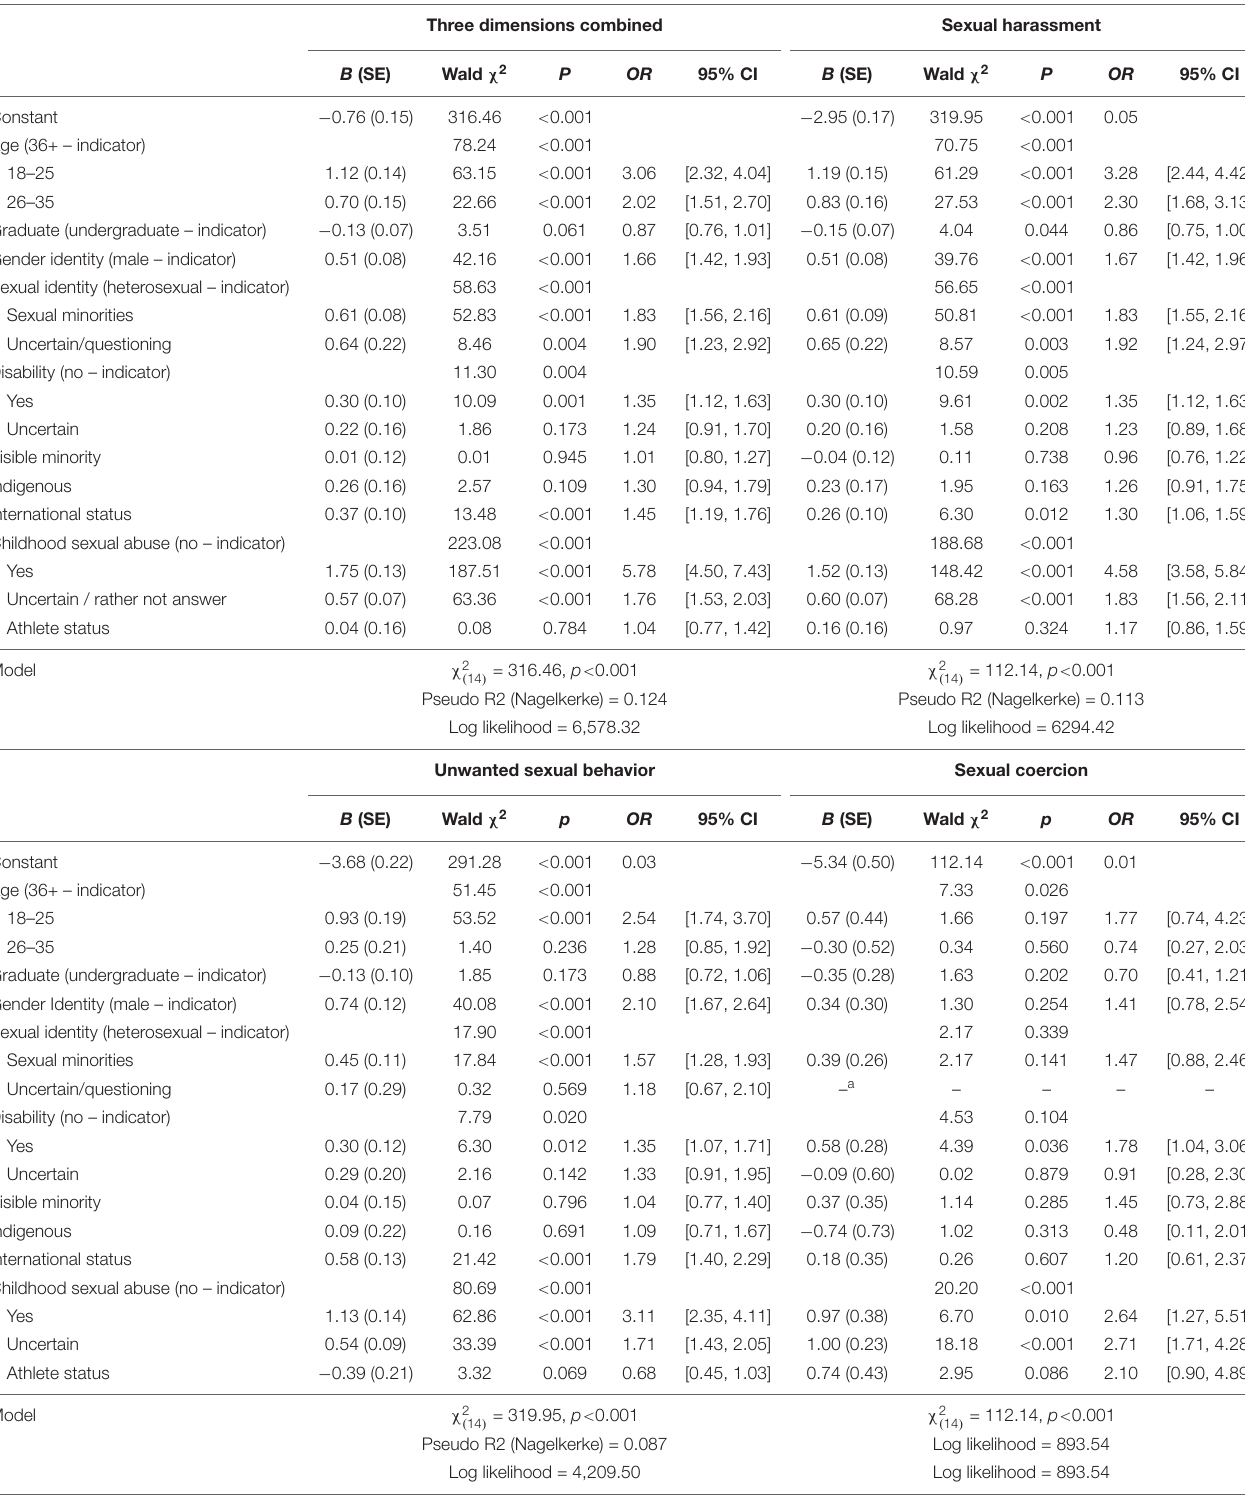
TABLE 2 | Logistic regression analyses of university-based sexual violence in the last 12 months ( n = 6,113). Three dimensions combined Sexual